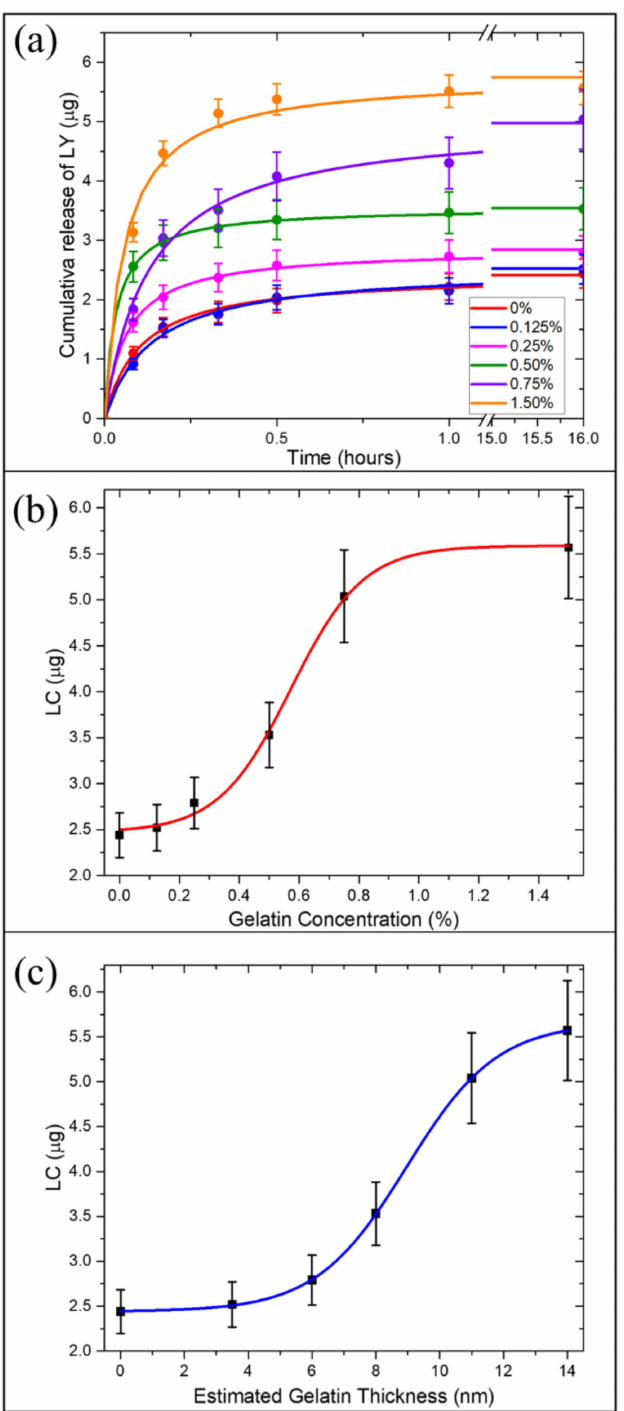
Figure 4. Correlation of the drug loading capacity of AuDNP-LY@Gel x with the gelatin shell. ( a ) Cumulative release of LY from AuDNP-LY@Gel samples with increasing concentration of the gelatin shell in PBS solution containing trypsin enzymes (60 µ g/mL). ( b ) Experimental estimation of the drug loading capacity in response to the concentration of the gelatin shell. ( c ) Theoretical estimation of the drug loading capacity according to the increasing thickness of the gelatin shell. The vertical bars are representative of the SD on a minimum of three independent